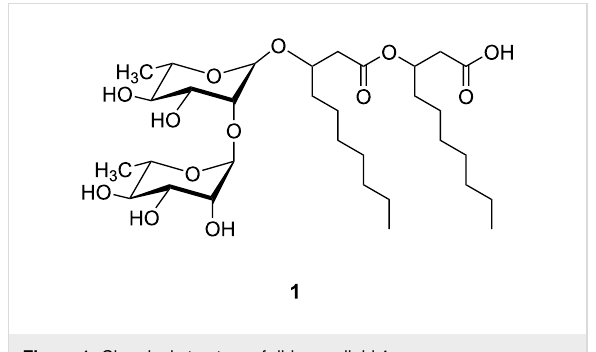
Figure 1: Chemical structure of dirhamnolipid 1